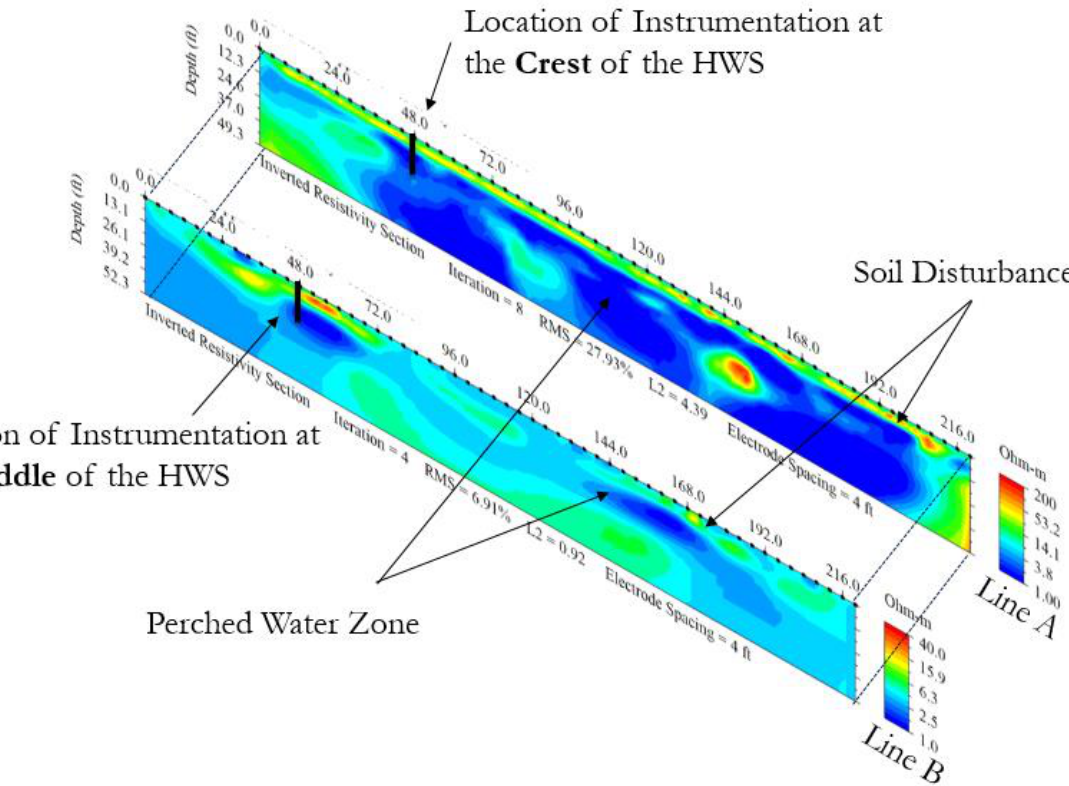
Figure 14. HWS 2, 2D ERI test profile at line A and at line B tested on 7 January 2021 (1 ft = 0.3 m).